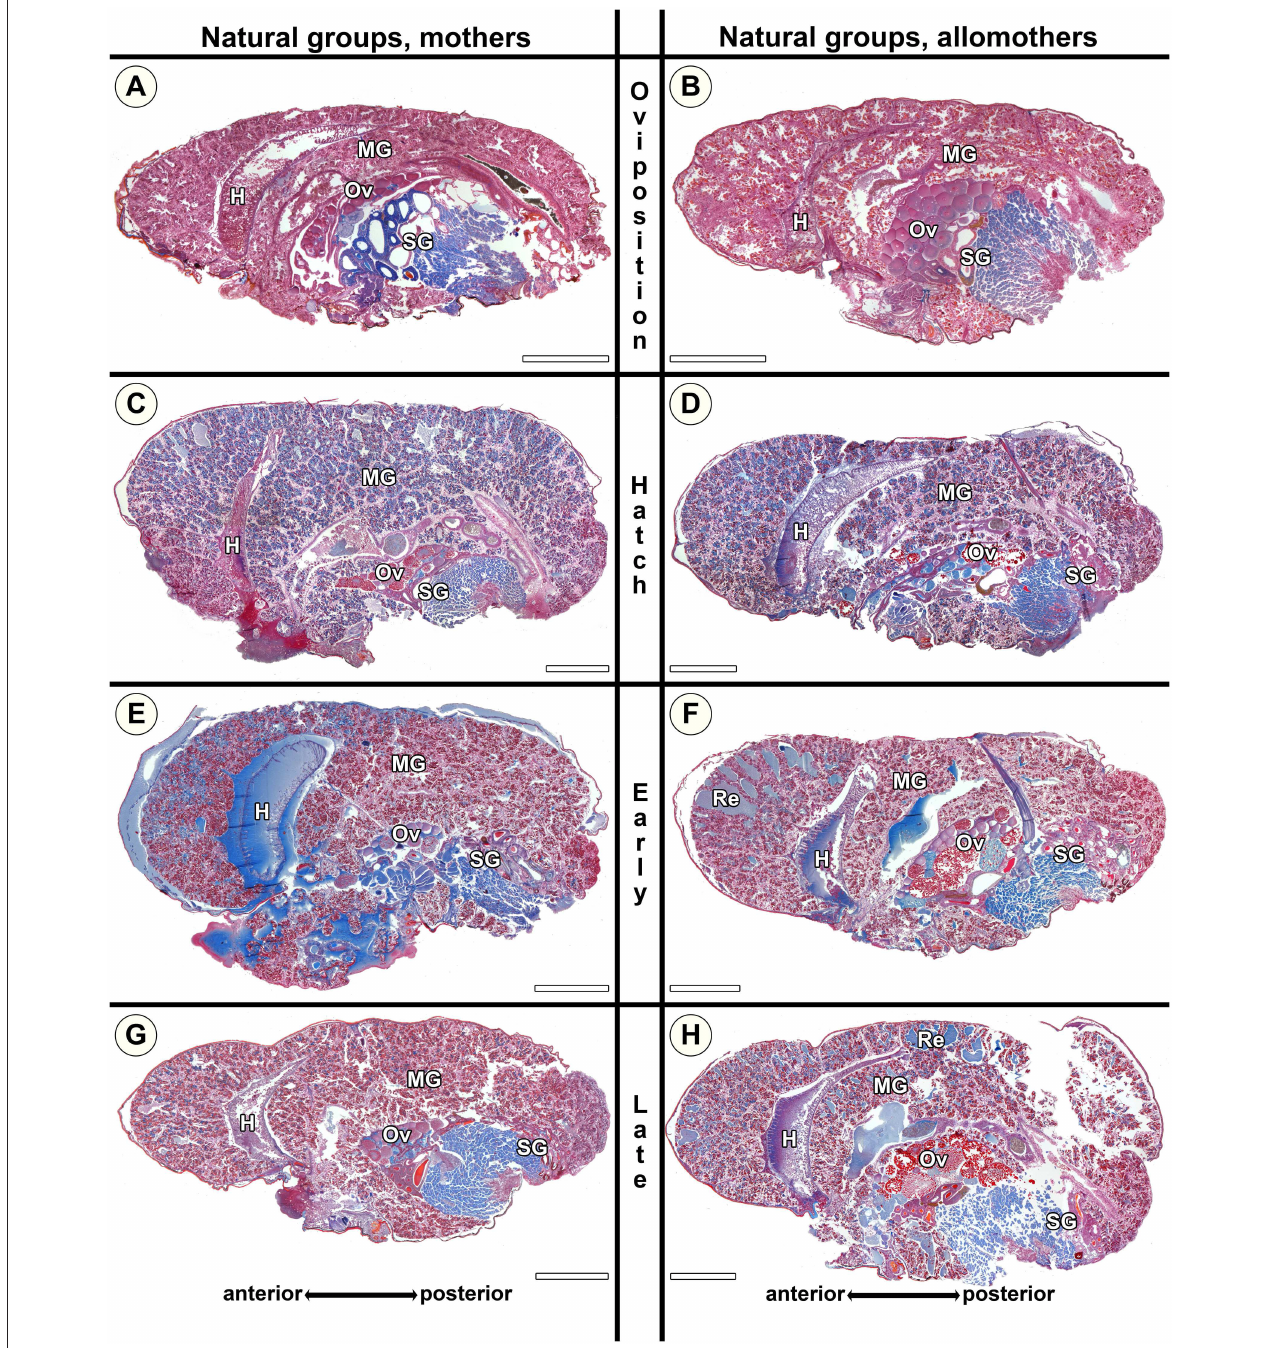
FIGURE 7 | Histological sections of opisthosomata of Stegodyphus dumicola mothers (left column) and allomothers (right column) of the natural group that followed a natural brood care cycle. Females were chemically fixed at (A,B) oviposition (No); (C,D) hatching of spiderlings (Nh); (E,F) early regurgitation phase (Ner; 6 days after hatching); (G,H) late regurgitation phase (Nlr; 24 days after hatching). Mothers as well as allomothers show similar changes with blue stained granules accumulating in the cells at the time of hatching (C,D) . Extracellular material is only visible in small amounts often in anterior parts of the midgut tissue (e.g., E,F ). Oocytes may undergo maturation in mothers (C) and allomothers (F,H) . H, heart; MG, midgut; Ov, ovary; Re, extracellular material (regurgitant); SG, silk gland. All scale bars are 2,000 µ m. they continuously accumulated extracellular fluids. This may that allomothers undergo similar changes in the midgut as reflect that allomothers care for all offspring produced by mothers. Already at the stage of hatching, allomothers appeared several mothers in the family group, i.e. in the event of unable to terminate and reverse these internal processes, instead,